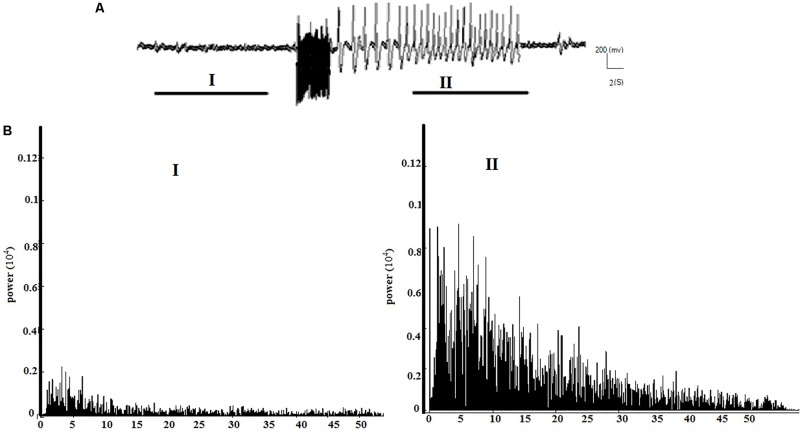
The spectral powers of the baseline and AD section of EEGs and the corresponding FFT analysis in the LFSK group. The LFSK and KLFS groups showed no significant differences in spectral powers. (A) A continuous baseline EEG (I) to the AD section EEG (II). (B) The spectral powers corresponding to baseline EEG and epileptic activities of the EEG signals.